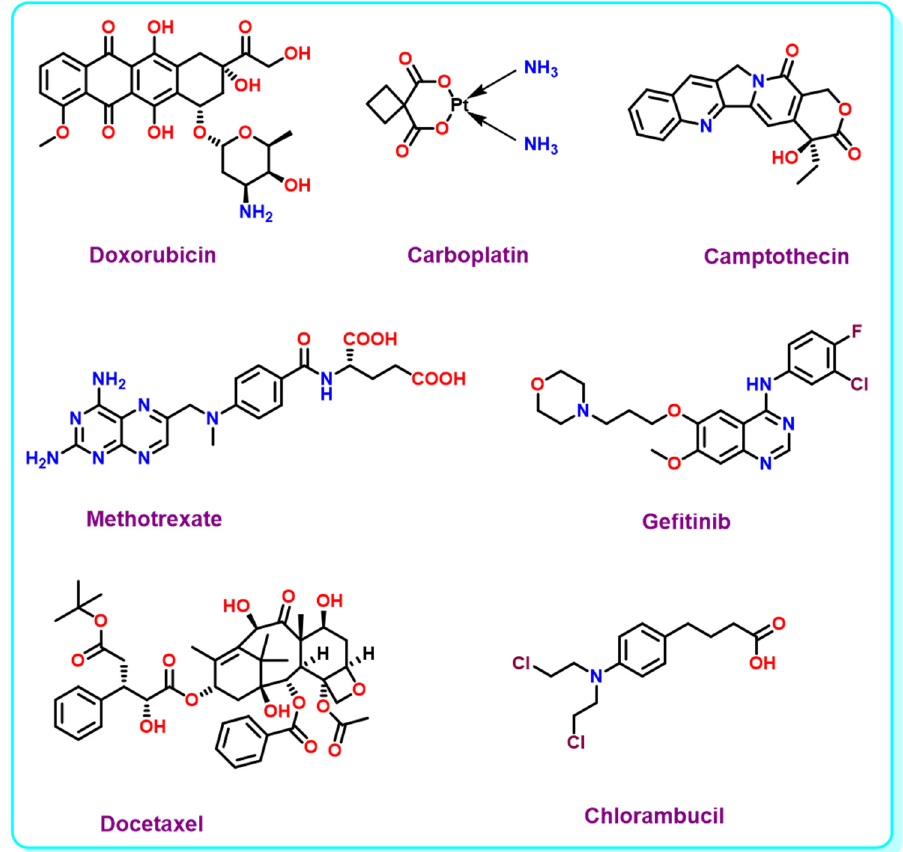
Figure 3. Structure of anticancer